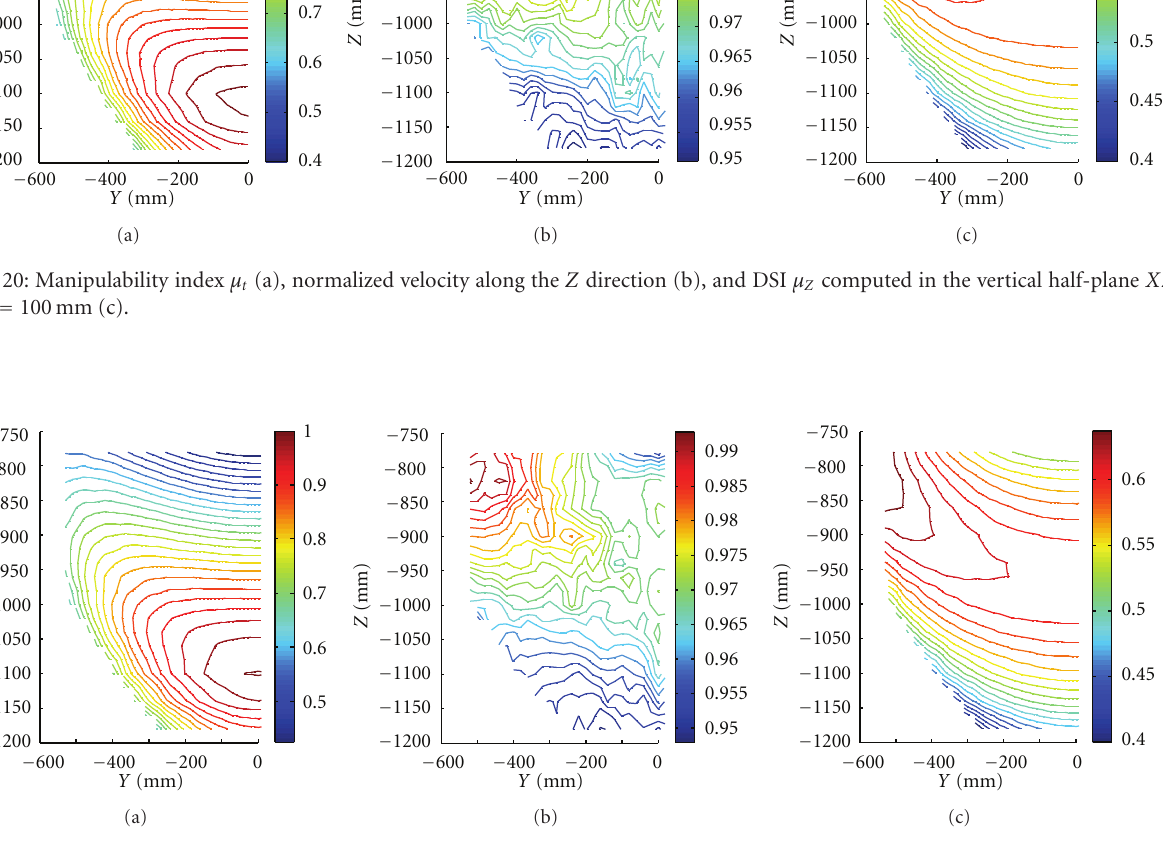
Figure 21: Manipulability index μ t (a), normalized velocity along the Z direction (b), and DSI μ Z computed in the vertical half-plane XZ with X = 200mm